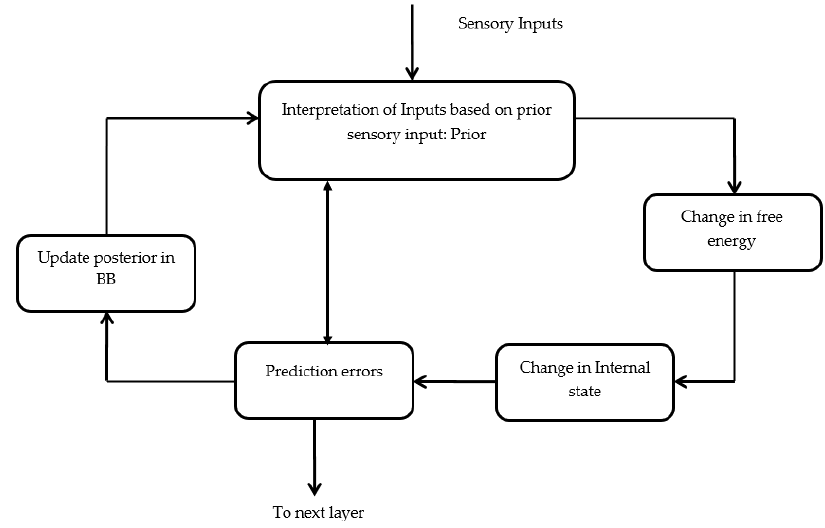
Figure 3. Relationship between Hierarchical BB and free energy principle.